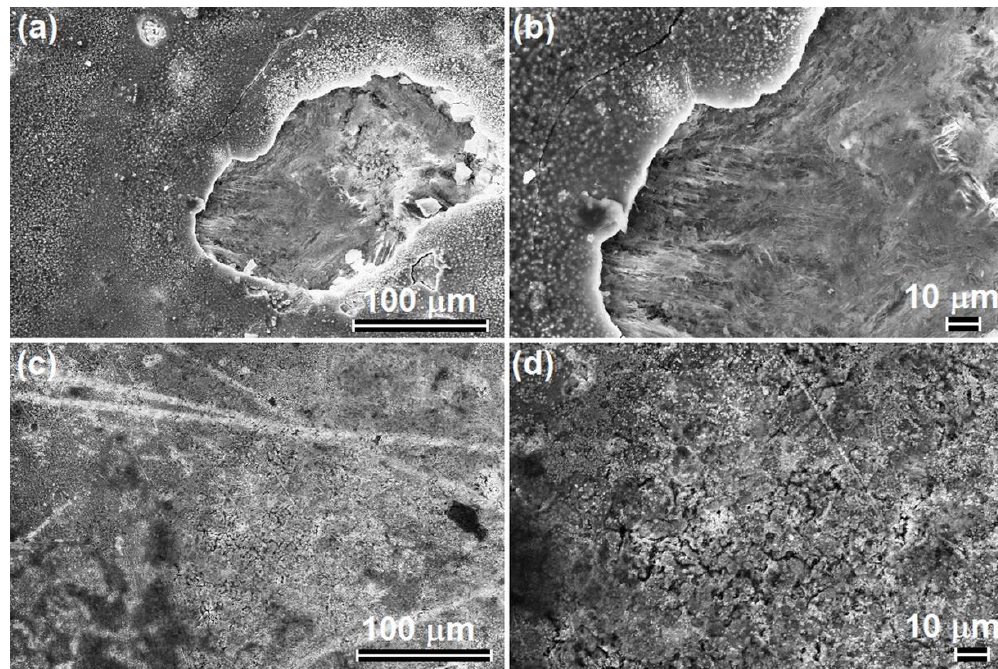
Figure 13. SEM micrographs of corroded samples after potentiodynamic testing: ( a ) a Zn-1Mg alloy corroded surface; ( b ) higher magnification showing degradation products on the surface; ( c ) general view of Zn-12.5Ag-1Mg corroded surface; and ( d ) detail of corrosion behavior along grain boundaries.